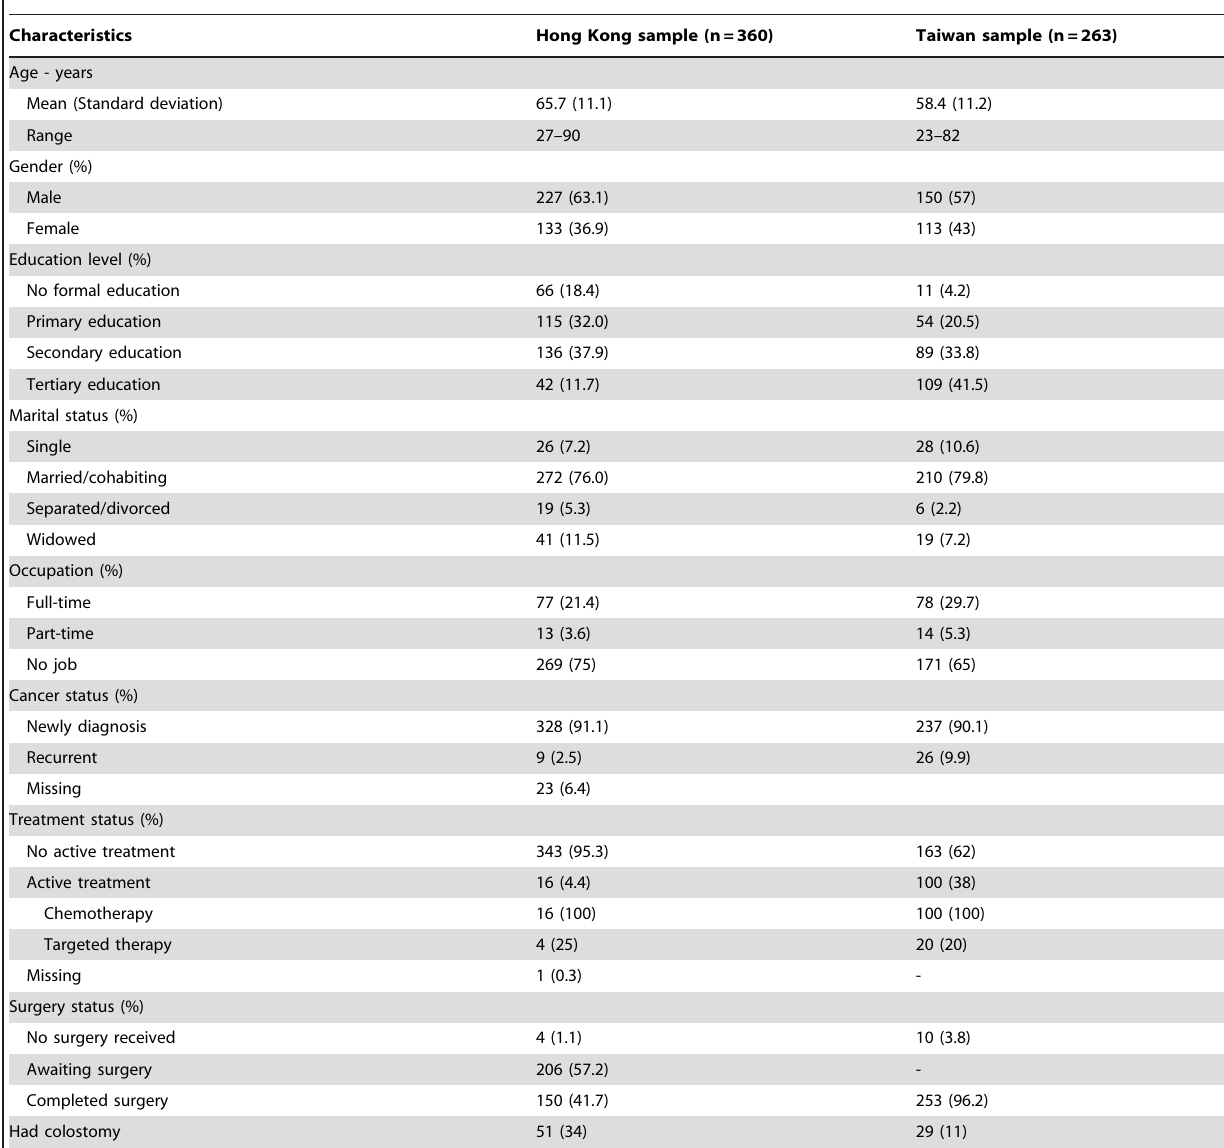
Table 1. Socio-demographic and clinical